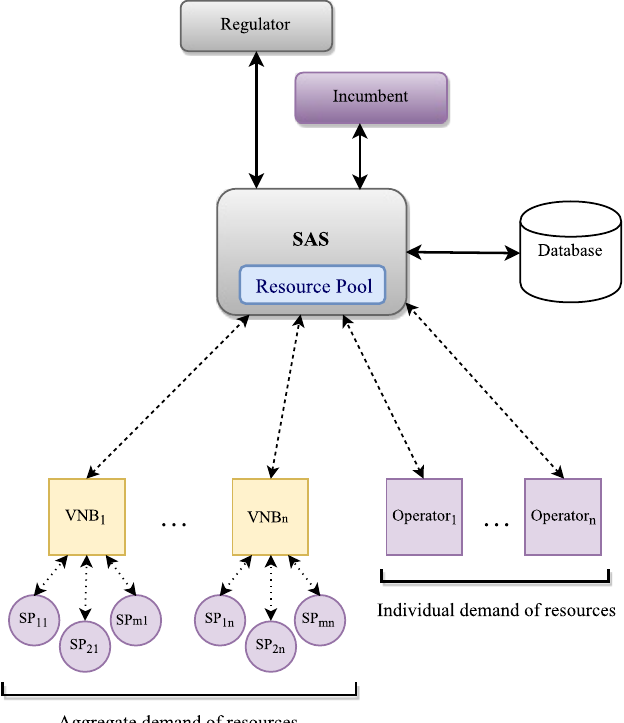
Figure 3. Virtual Network Builders as part of the sharing scheme in the 3.5 GHz